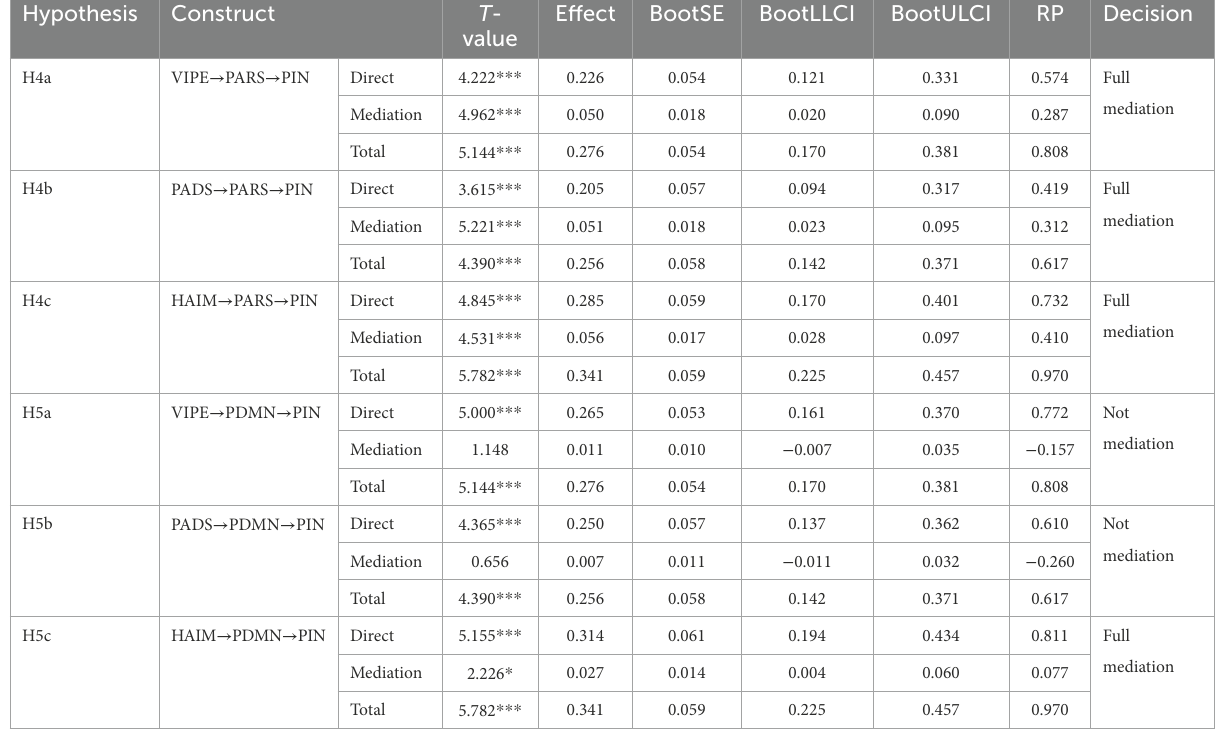
TABLE 8 Assessing mediation effects.